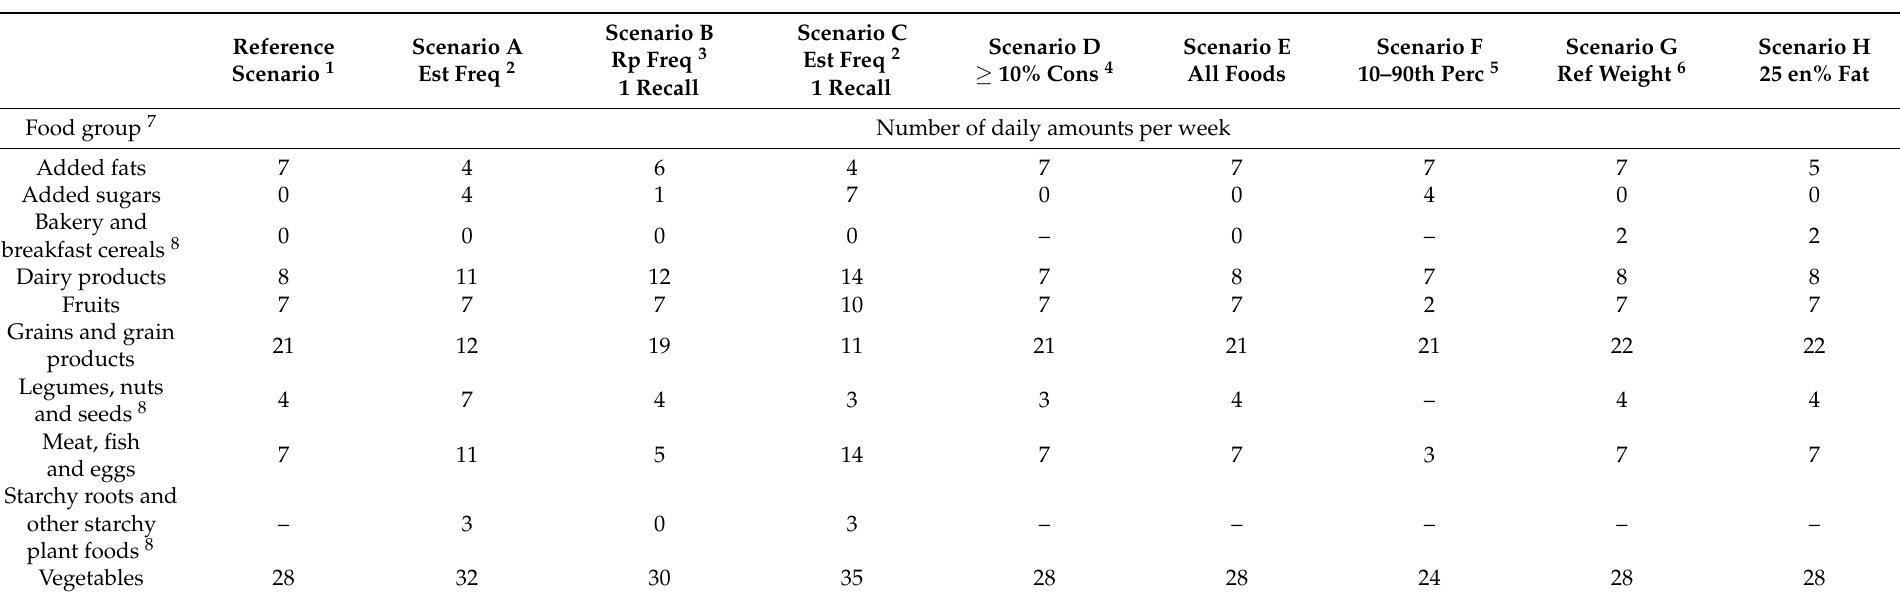
Table 3. Draft FBR in frequency per week for the reference scenario and alternative scenarios defined in Optifood module 2 for Kenyan children, 4–6 years of